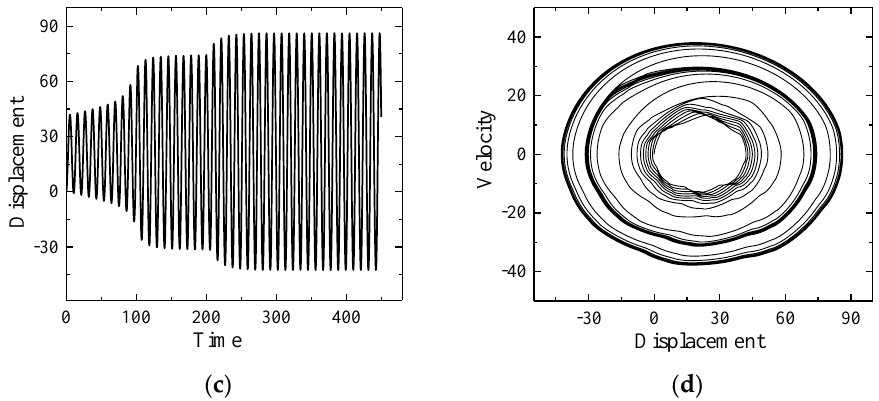
Figure 16. Evolutions of the displacement and speed-displacement diagram of brake disc and brake shoe at the normal braking load of 80 N. ( a ) Evolution of the displacement of the brake shoe. ( b ) Evolution of the speed-displacement diagram of the brake shoe. ( c ) Evolution of the displacement of the brake disc. ( d ) Evolution of the speed-displacement diagram of the brake disc.